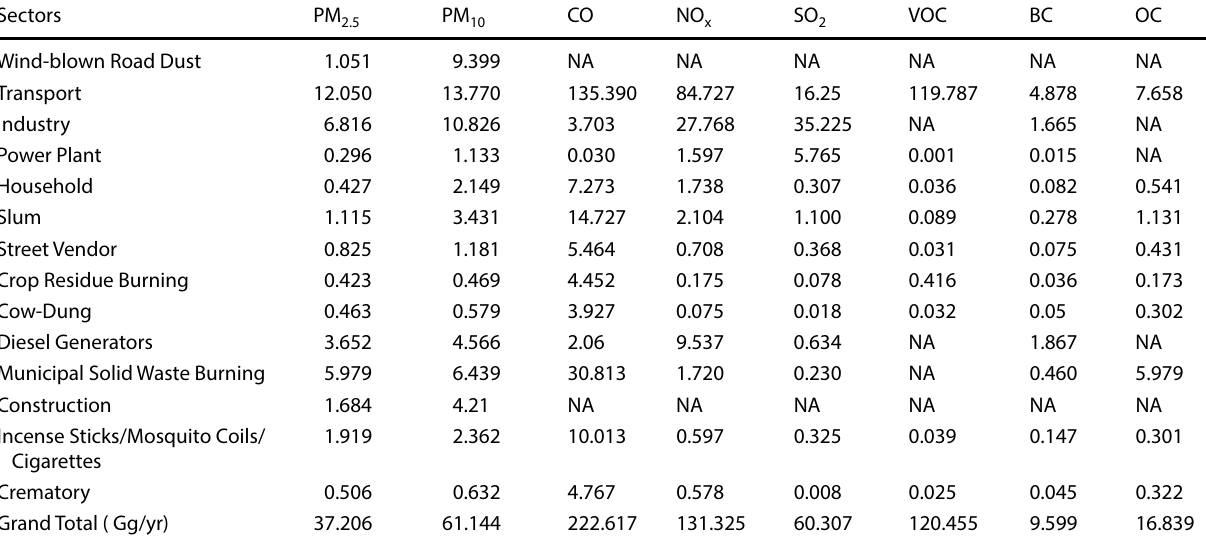
Table 1 Sector-wise annual emissions (in Gg/yr) for Kolkata Sectors PM